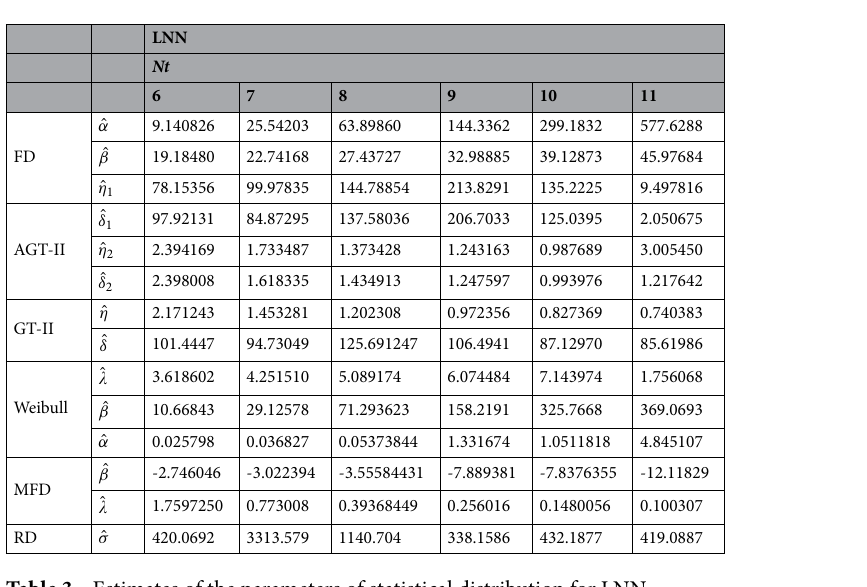
Table 3. Estimates of the parameters of statistical distribution for